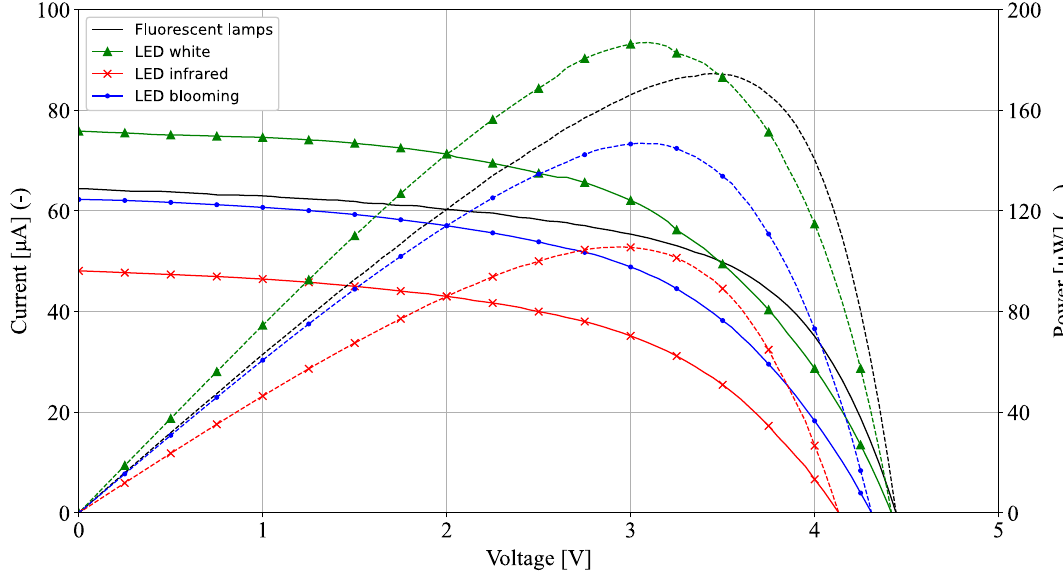
Figure 10. DC I–V (solid lines) and P–V (dashed lines) characteristics of the flexible ambient-light photovoltaic cell, when illuminated with fluorescent lamps and different types of LED lights. Fluorescent lamps (no marker), LED white (marker ‘upward triangle’), LED infrared (marker ‘times’), LED blooming (marker ‘dot’).